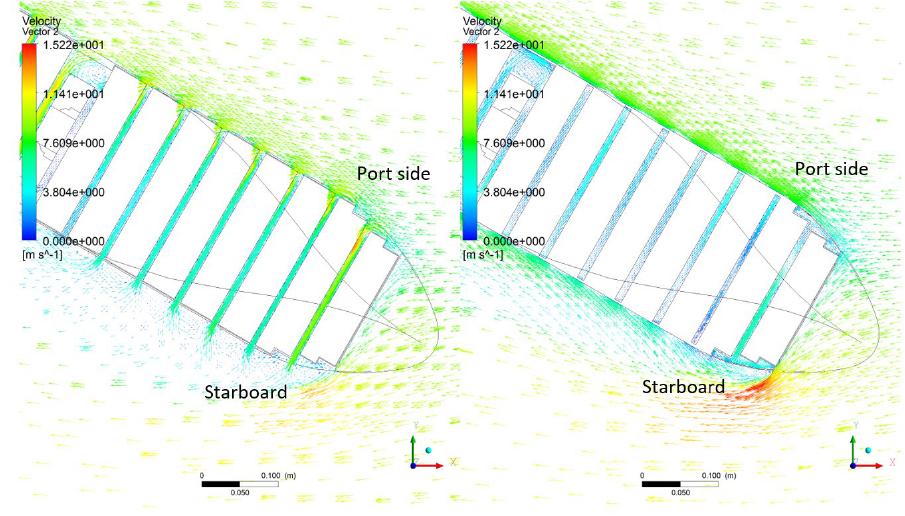
Figure 33. Velocity vector near the bow, at z = 0.12 m, ψ = 30 degrees. (Left: without side covers; Right: with side covers).